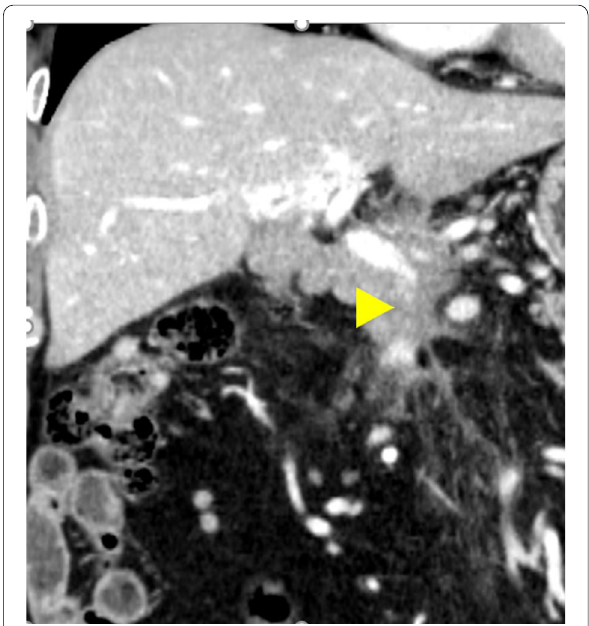
Fig. 1 Follow-up computed tomography a year and 6 months after pancreaticoduodenectomy (coronal image). The superior mesenteric vein was obstructed near the splenic vein confluence (arrowhead)